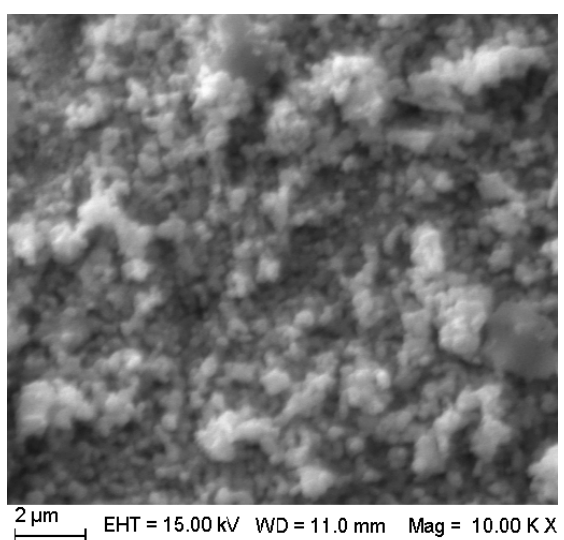
Figure 5. SEM images of pure SrTiO 3 .